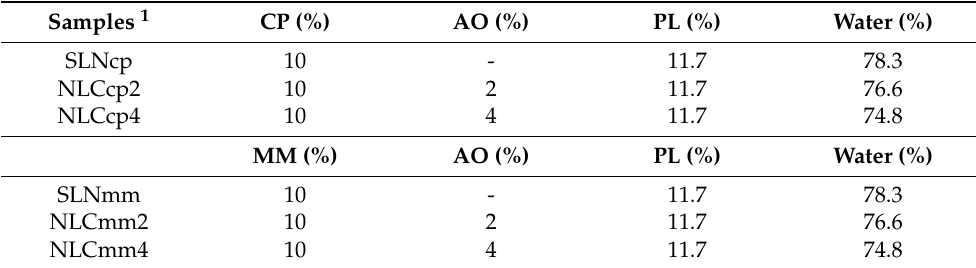
Table 1. Composition of lipid